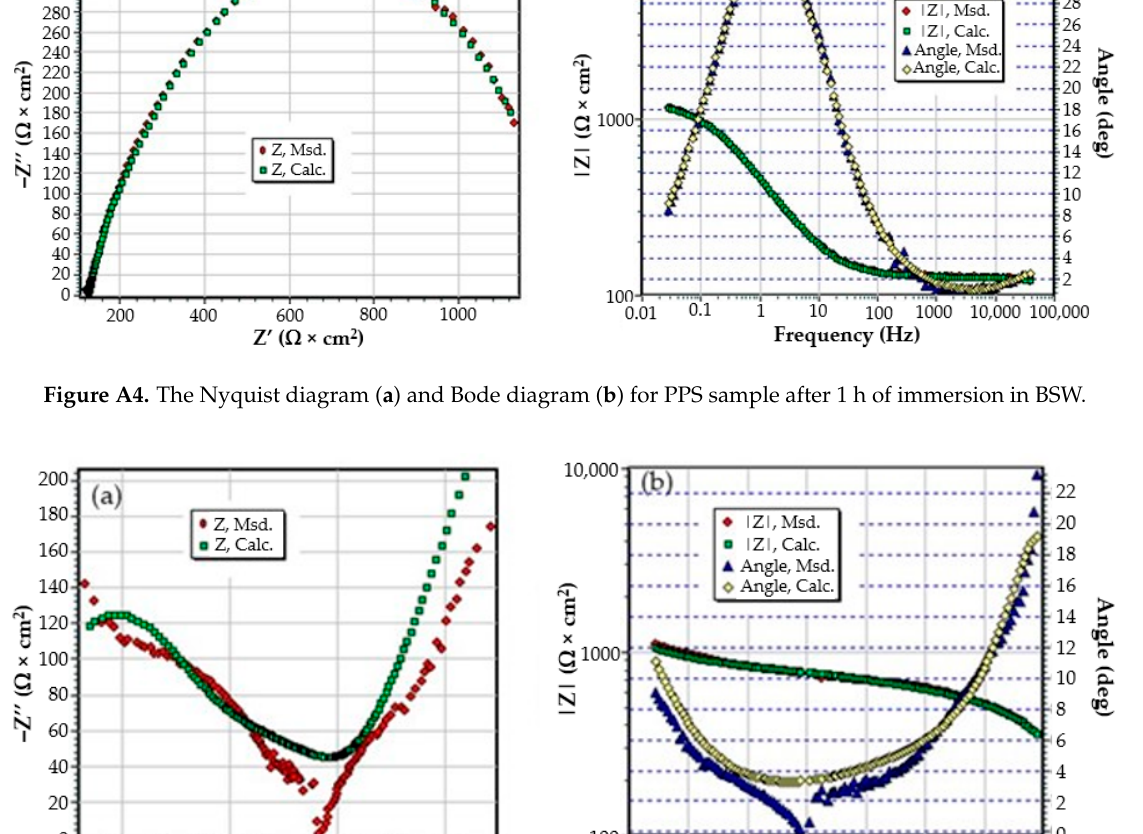
Figure A5. The Nyquist diagram ( a ) and Bode diagram ( b ) for PPS sample after 36 days of immersion in BSW.